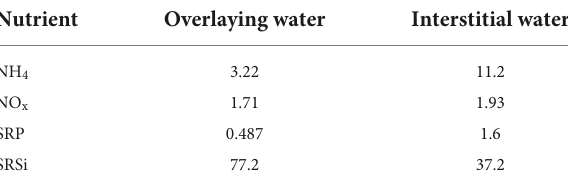
TABLE 1 Molar concentrations ( µ mol L − 1 ) of main inorganic nutrients measured in the overlaying and interstitial water of the microbial mat at the beginning of the